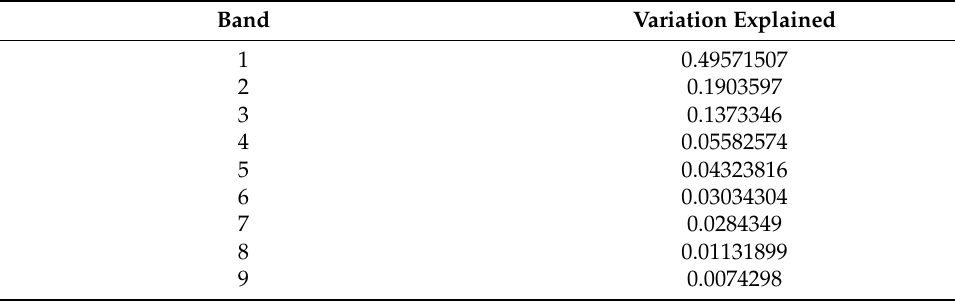
Table A7. TLS PCA band variation explained at 0.5 m grid